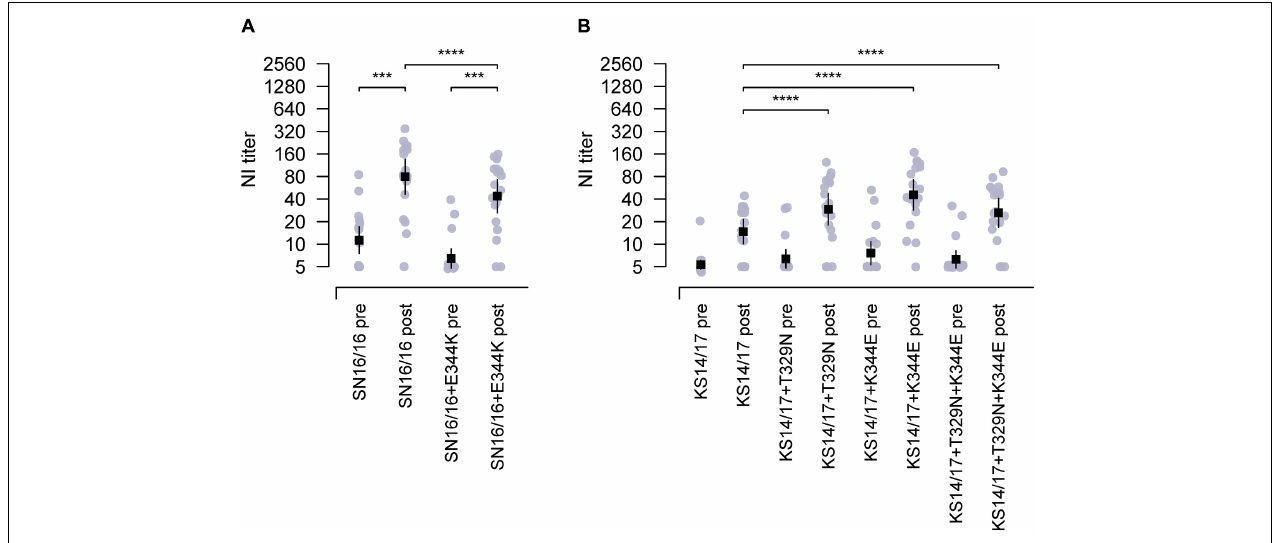
FIGURE 4 | The epitopes of 329 N -glycosylation and E344 targeting by the antisera from children during 2018–2019. (A) Reduced NI activity of the antisera in children to E344K mutants using RGH6N1-SN16/16 + E344K compared with RGH6N1-SN16/16. (B) Enhanced NI activity of antisera in children to RGH6N1-KS14/17 + T329N, RGH6N1-KS14/17 + K344E, or RGH6N1-KS14/17 + T329N + K344E compared with RGH6N1-KS14/17. The sera of children collected in the pre– and post–flu season were for tests. The mean ± 95% CI is shown. p- value is indicated. *** < 0.001, **** <